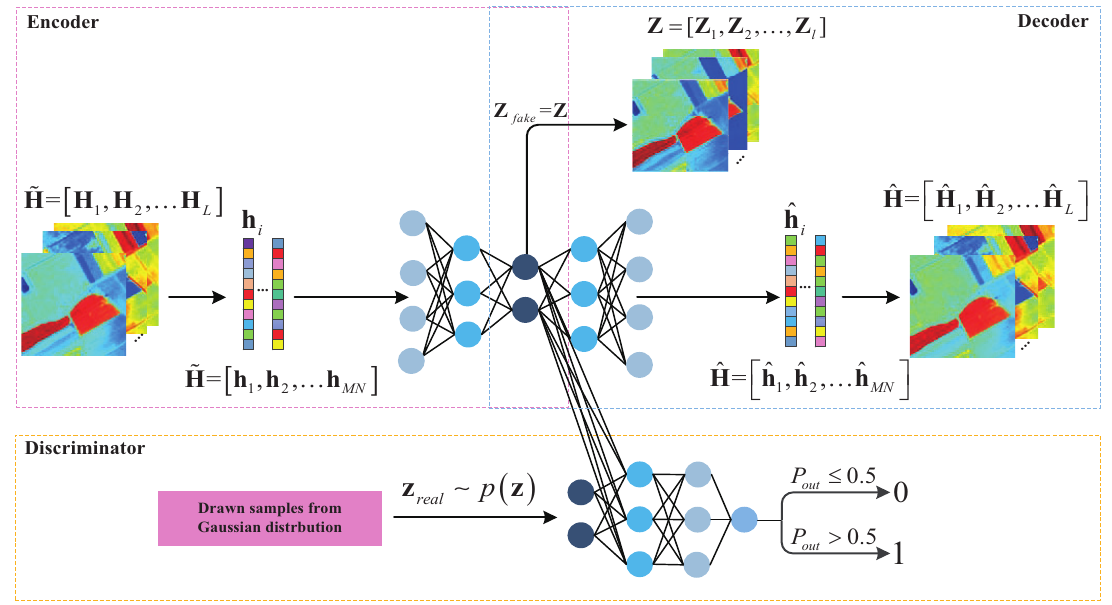
Figure 2. The process of feature extraction by